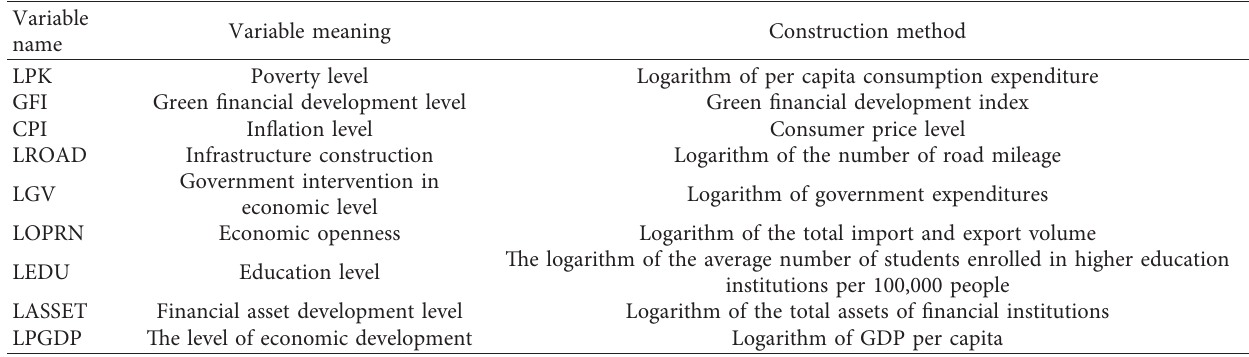
Table 2: Measures of major variables.